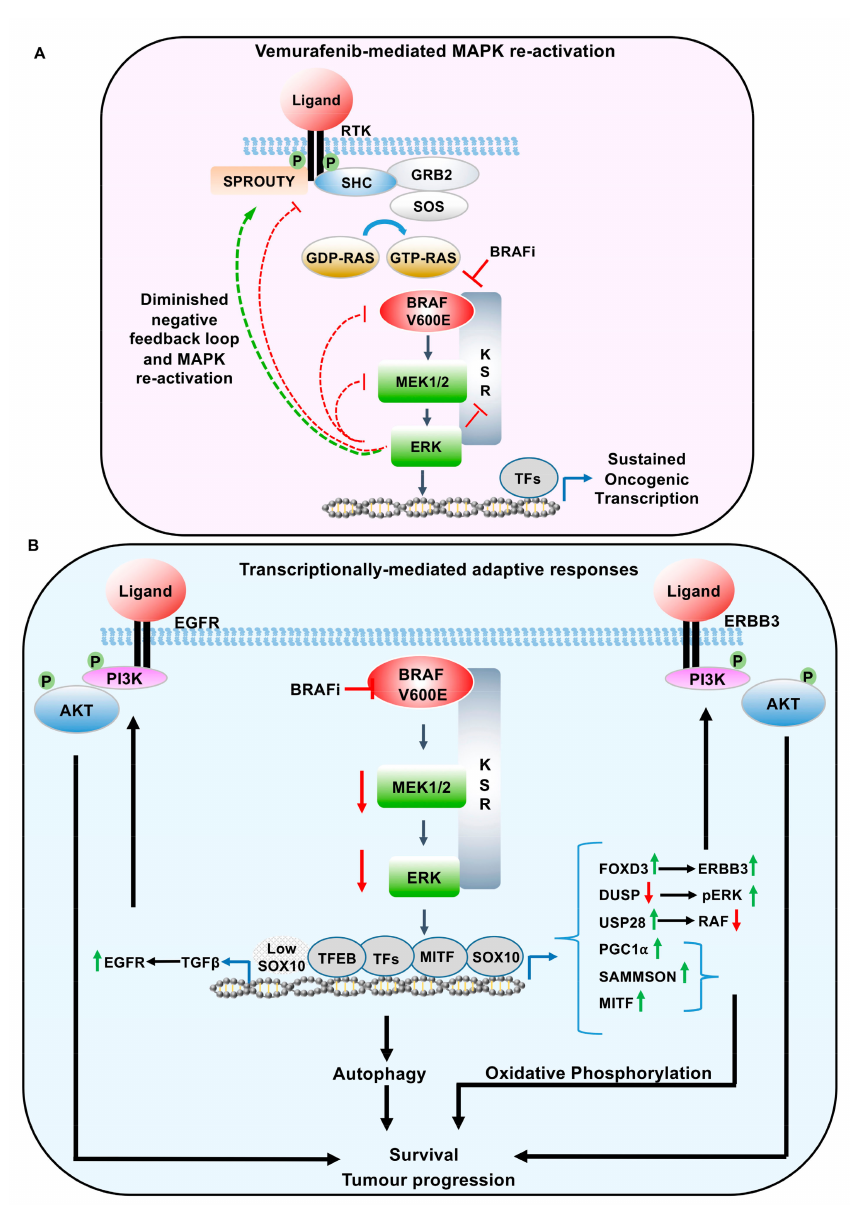
Figure 3. Adaptive response-mediated resistance to BRAF inhibitors in melanoma. ( A ) Negative feedback regulation of activated ERK on EGFR, RAF, and MEK, resulting in the downregulation of MAPK signalling. Figure 3 highlights the relief of these downstream kinase-dependent negative feedback loops, following MAPK inhibition. ( B ) Transcriptionally-mediated feedback loops regulating resistance to BRAF inhibitors. These feedback loops result in re-activation of the MAPK pathway (DUSP, USP28, FOXD3 / ERBB3. TGFB / EGFR), parallel activation of PI3K pathway (FOXD3 / ERBB3, TGFB / EGFR), increase oxidative phosphorylation (PGC1 α , lncRNA SAMMSON, MITF), and autophagy related genes mediated by TFEB. RAF, RAF proto oncogene; MEK / MAPK, mitogen-activated protein kinase; ERK, extracellular signal-related kinase. SHC, SHC adaptor protein 1; GRB2, growth factor receptor bound protein 2; SOS, son of sevenless; RAS, RAS proto-oncogene; USP28, Ubiquitin specific protease 28; KSR, Kinase Suppressor of RAS; EGFR, epidermal growth factor receptor; ERBB3, Erb-B2 receptor tyrosine kinase 3; PI3K, Phosphoinositide 3-kinase; AKT, AKT serine / threonine kinase; MITF, melanocyte inducing transcription factor; SOX10, SRY-box 10; TGF β , transforming growth factor β , TFEB, transcription factor EB; FOXD3, forkhead box D3; DUSP, dual specificity phosphatase; PGC1 α , Peroxisome proliferator-activated receptor-gamma coactivator (PGC)-1alpha, TF, transcription